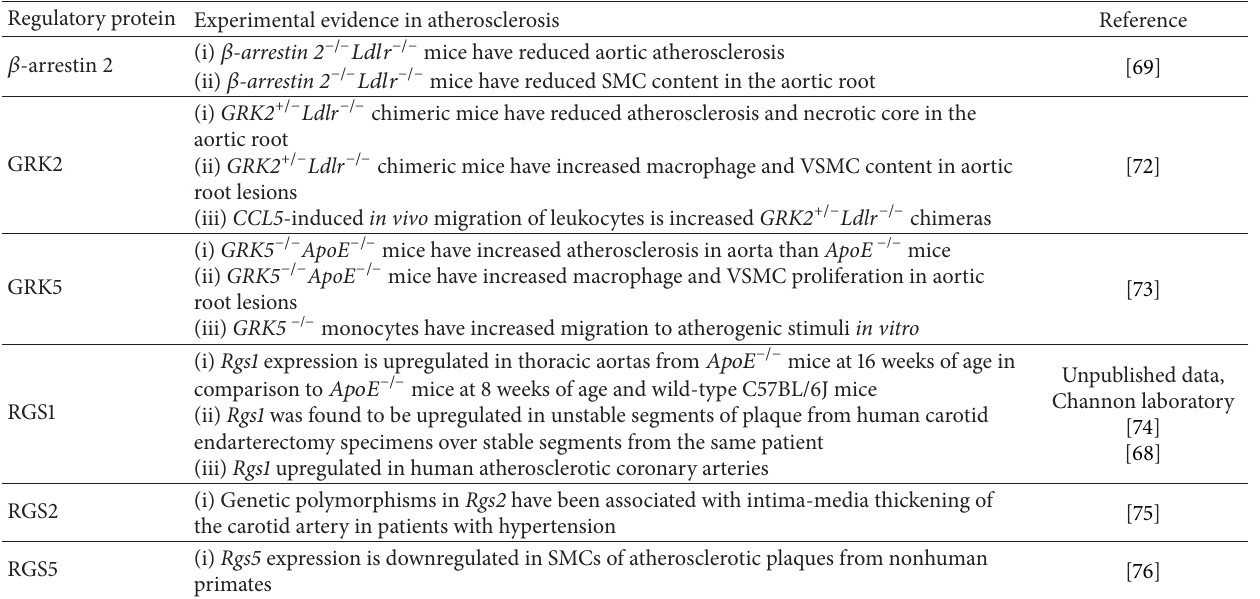
Figure 2: GRKs and arrestins in chemokine-mediated GPCR signalling. Following receptor activation and G-protein dissociation (1) downstream signalling pathways are activated (2). Ligand-activated GPCRs are phosphorylated by GRKs (3), resulting in the recruitment of arrestins (4). This uncouples the receptor from its G-protein, thereby attenuating further receptor signalling. The binding of arrestins to the receptor promotes internalisation of the receptor (5) that can result in the down-regulation of receptor, but can also contribute to a second round of signalling such as activation of the MAPK cascade (6). Table 1: GPCR signalling regulatory proteins in